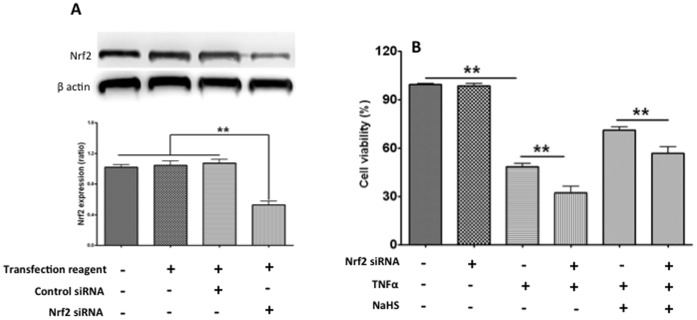
The protective effect of Sodium Hydrosulphide (NaHS) via Nrf2 in vitro.Nrf2 knockdown with siRNA [upper panel: example bands of Nrf2 and internal control of housekeeping protein β-actin; bottom panel: mean data (mean ± SEM; n = 3) of Nrf2 normalised with β-actin] in the cultures of pulmonary micro-vessel endothelial cells (A). The viability of pulmonary micro-vessel endothelial cells with or without knockdown of Nrf2 was determined with 3-(4, 5-Dimethyl-2-thiazolyl)-2, 5- diphenyl-2H-tetrazolium bromide (MTT) assay in the presence or absence of TNF-α/NaHS (B). Data are mean ± SEM (n = 12); ** p<0.01.